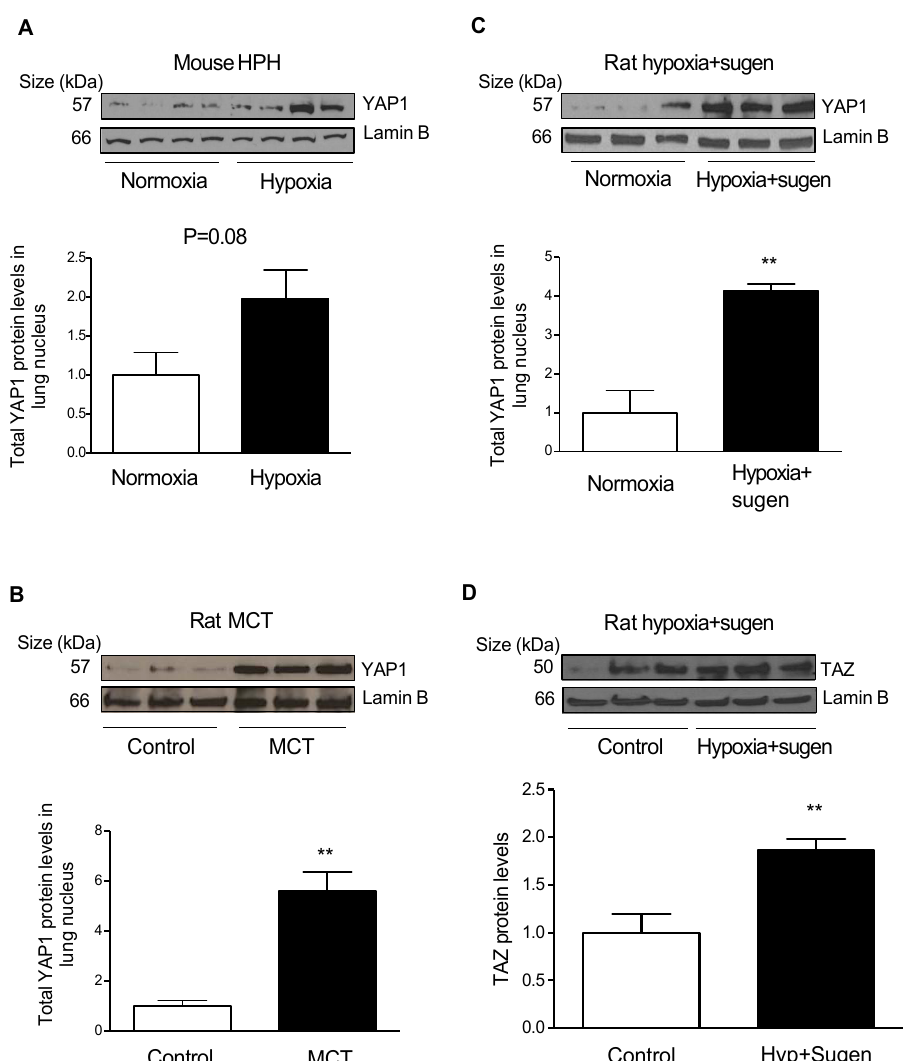
Figure 5. Upregulation of YAP1 and TAZ in rodent models of pulmonary hypertension. ( A ) Representative Western blot images and Lamin B-normalized quantification of protein demonstrate that YAP1 expression has an increasing trend in mouse lungs after 4 weeks of hypoxia exposure; ( B ) representative Western blot images and Lamin B-normalized quantification of protein demonstrate that YAP1 expression increased significantly in lung tissues from monocrotaline (MCT)-mediated pulmonary hypertension in rats; ( C ) representative Western blot images and Lamin B-normalized quantification of protein demonstrate that YAP1 expression increased significantly in lung tissues from hypoxia + Sugen-mediated pulmonary hypertension in rats; ( D ) representative Western blot images and Lamin B-normalized quantification of protein demonstrate that TAZ expression in- creased significantly in lung tissues from hypoxia + Sugen-mediated pulmonary hypertension in rats. ** p < 0.01 versus controls, n = 3–4 per